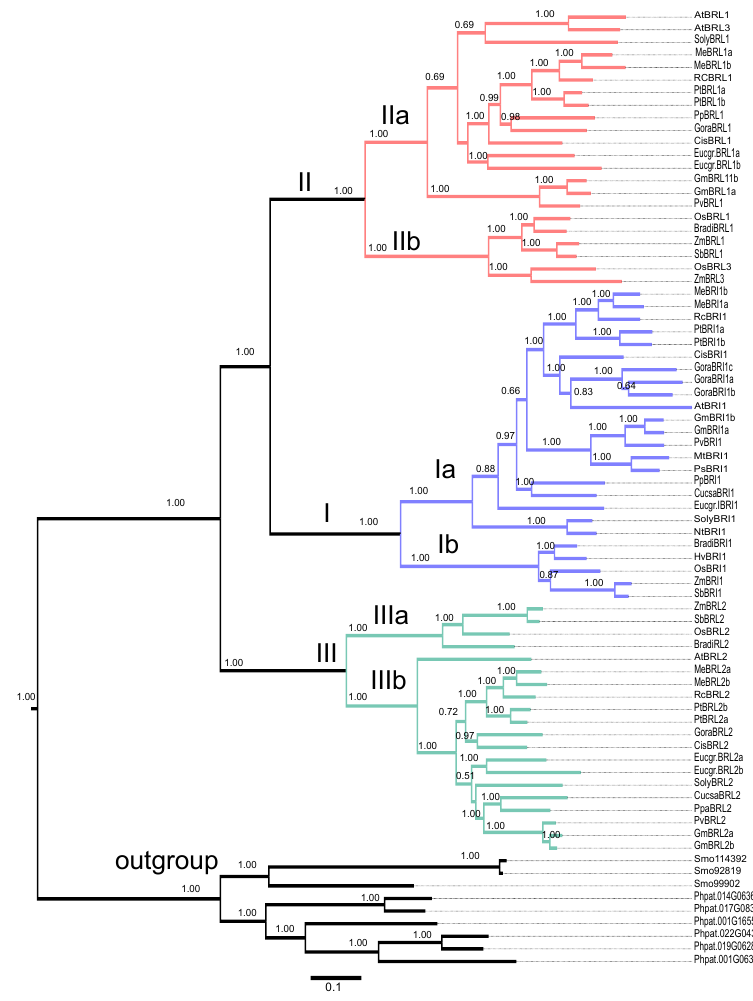
Figure 10. Evolutionary analysis of BR receptors in plants. BLASTP was used to search for BR receptor homologs in different plant species. A total of 76 BR receptors as shown in Spreadsheet S1 were analyzed from monocots ( Oryza sativa (Os), Zea mays (Zm), Sorghum bicolor (Sb), Brachypodium distachyon (Bradi)), dicots ( Arabidopsis thaliana (At), Glycine max (Gm), Solanum lycopersicum (Soly), Medicago truncatula (Mt), Phaseolus vulgaris (Pv), Populus trichocarpa (Pt), Eucalyptus grandis (Eucgr), Citrus sinensis (Cis), Gossypium raimondii (Gora), Cucumis sativa (Cusa), Prunus persica (Pp), Manihot esculenta (Me), Ricinus communis (Rc), and Nicotiana tabacum (Nt)), moss ( Physcomitrella patens (Phpat)), and fern ( Selaginella moelledorffii (Smo)) and grouped into three clades, CladesI, II, and III. Additionally, nine BR receptor homologs from moss and fern were determined to be members of an outgroup. The values above the branches are the probability of the bootstrap value with 1000 repeats. MrBayes 3.2 software was used to reconstruct the phylogenetic tree as described in the Methods Section. Scale bar indicates 0.1 amino acid substitution over